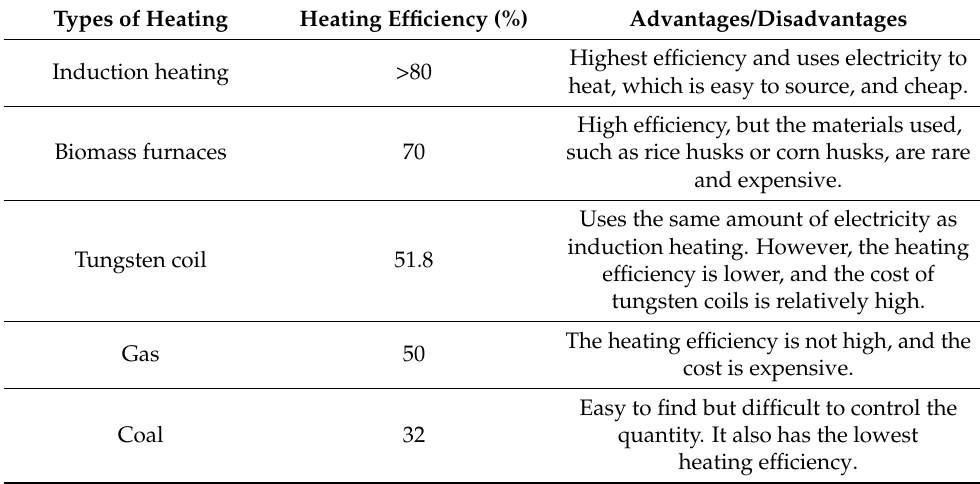
Table 6. Comparison of heating efficiency for different types of